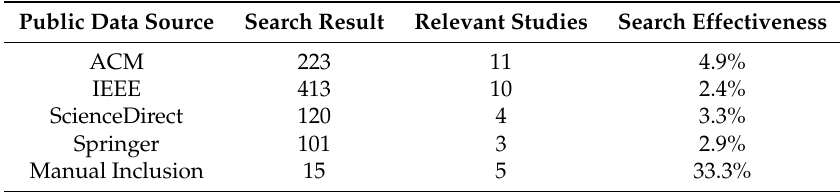
Table 1. Selection process overview per public data source.